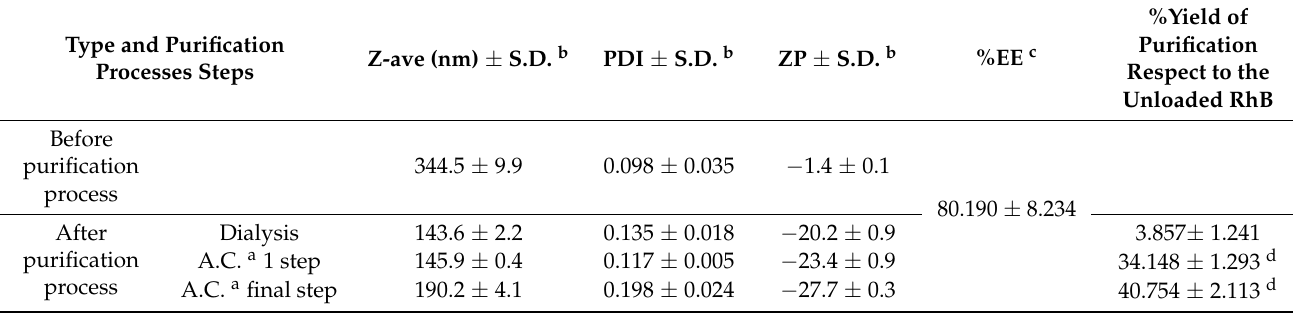
Table 1. Chemicophysical properties and yield of purification of loaded-PNPs purified through centrifugation and dialysis